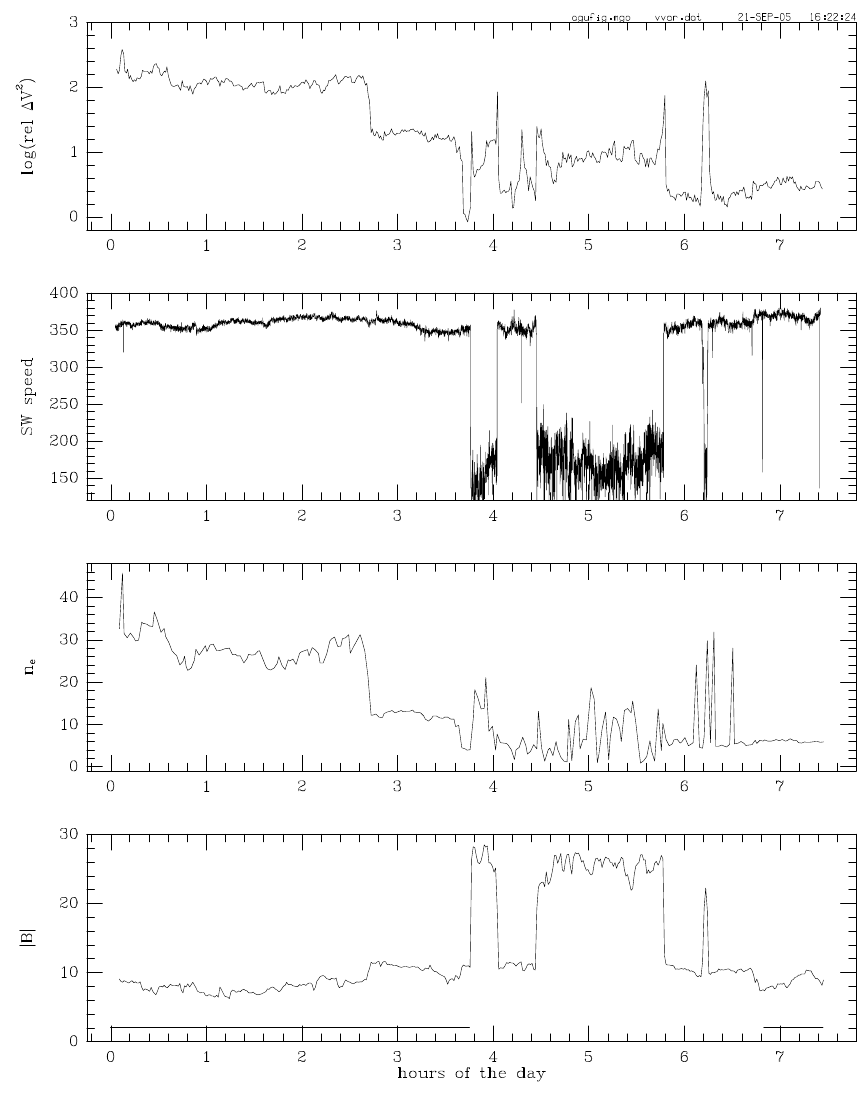
Fig. 2. Some data pertaining to the spacecraft